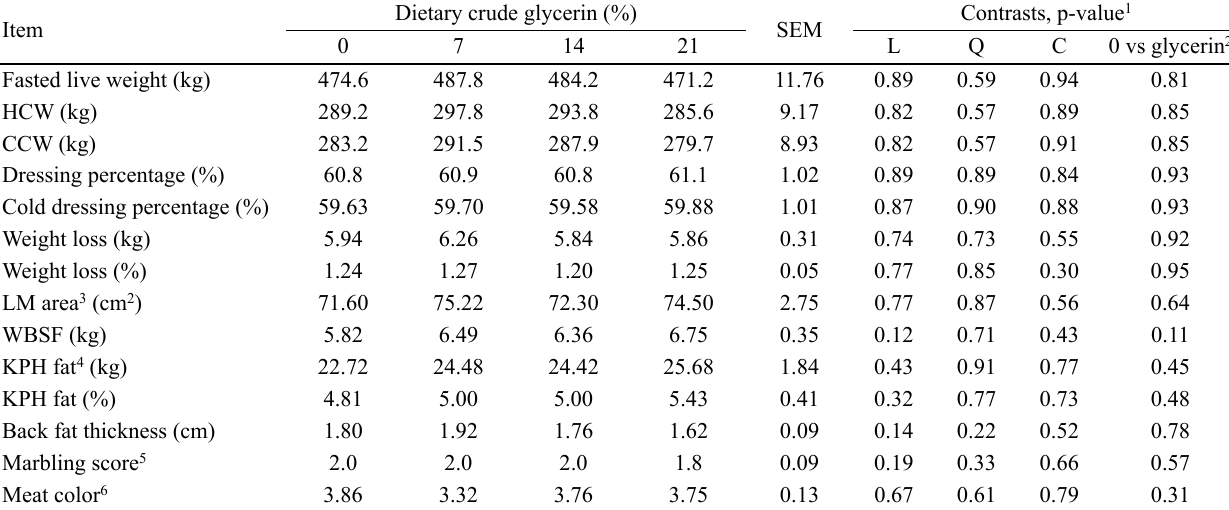
Table 4. Effects of dietary crude glycerin on carcass characteristics of finishing steers